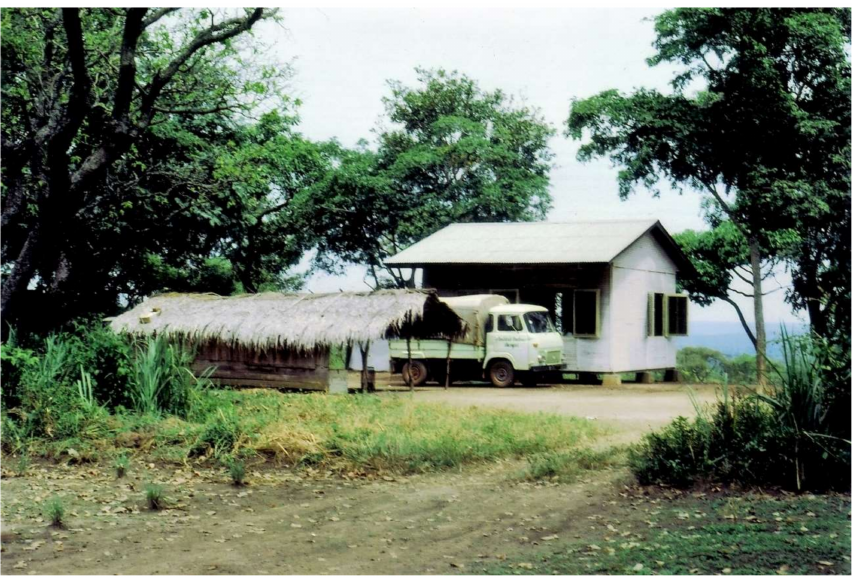
Figure 1. The field station in Bozo, Central African